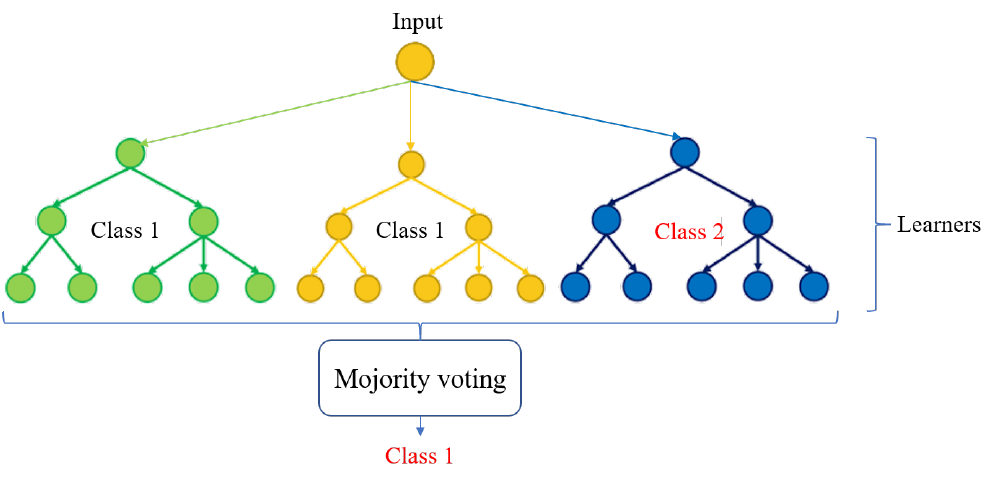
Figure 9. Random forest structure.